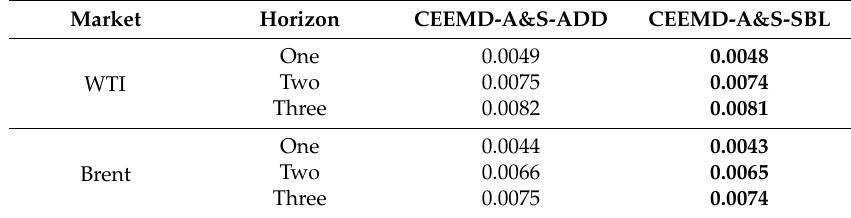
Table 12. The MAPE values of different prediction models on WTI and Brent crude oil prices.